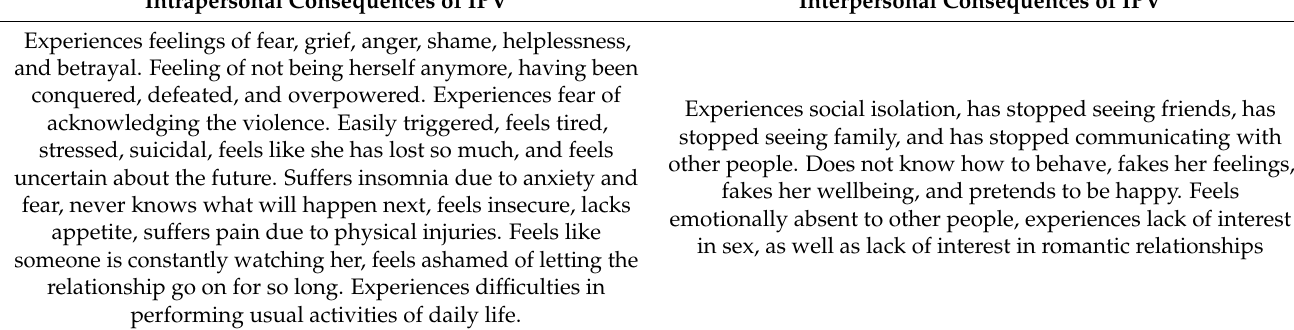
Table 7. Component 4: Overview of the intrapersonal and interpersonal consequences of IPV, according to the women participating in the